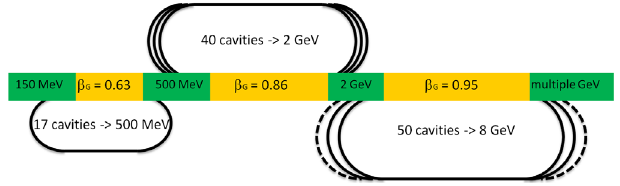
FIG. 1. A schematic plot of a GeV recirculating proton linac